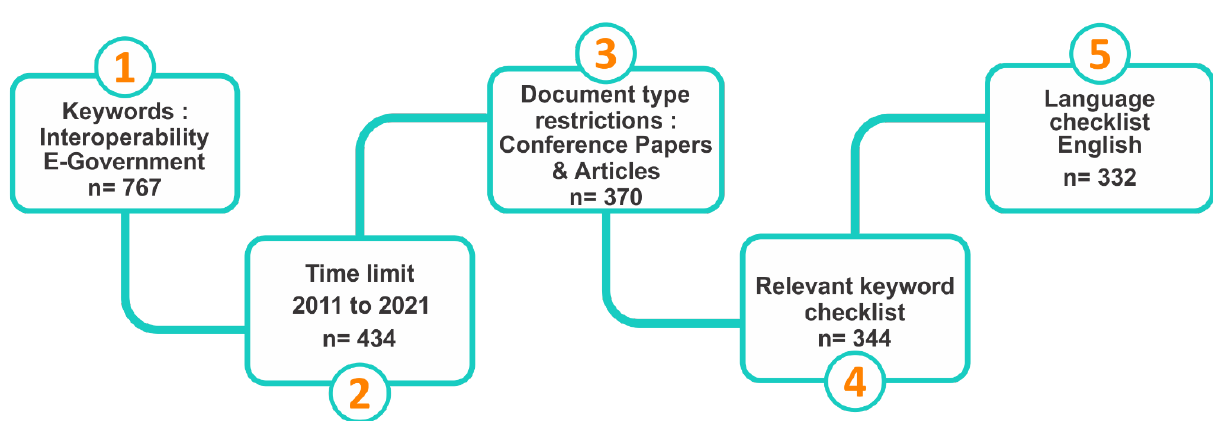
Figure 1: Data Mining Step. Source: Created by the